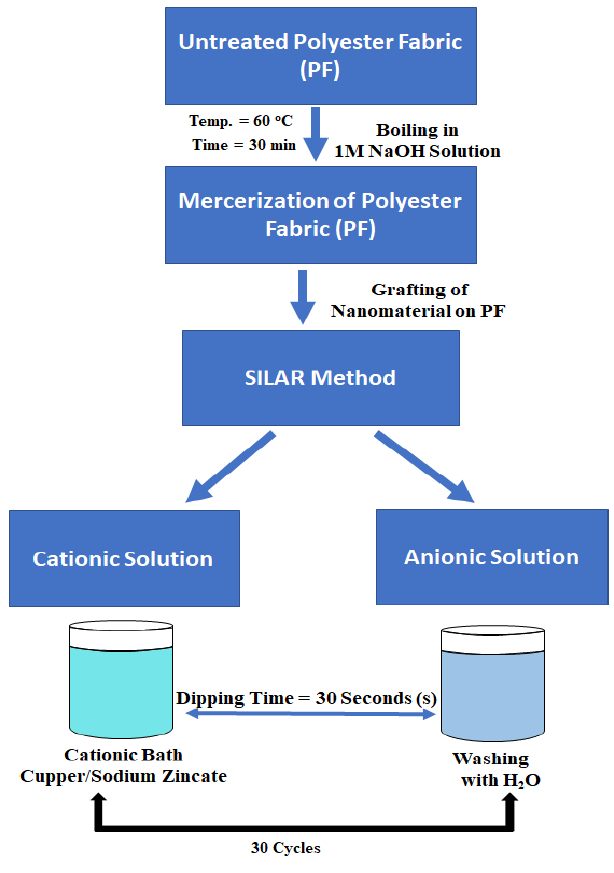
Figure 1. Schematic diagram of pathway followed for grafting of (ZnO/CuO) nanocomposite onto the surface of polyester.